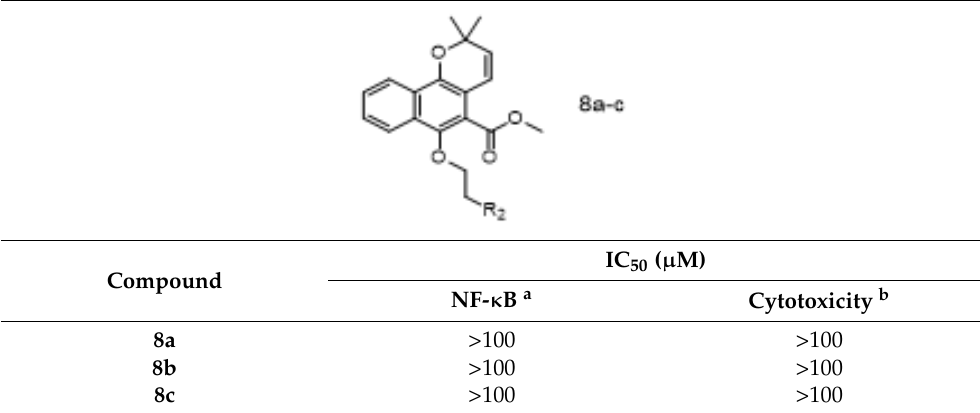
Table 3. In vitro inhibition of NF- κB transcriptional activity and cytotoxicity of the compounds 8a- c.